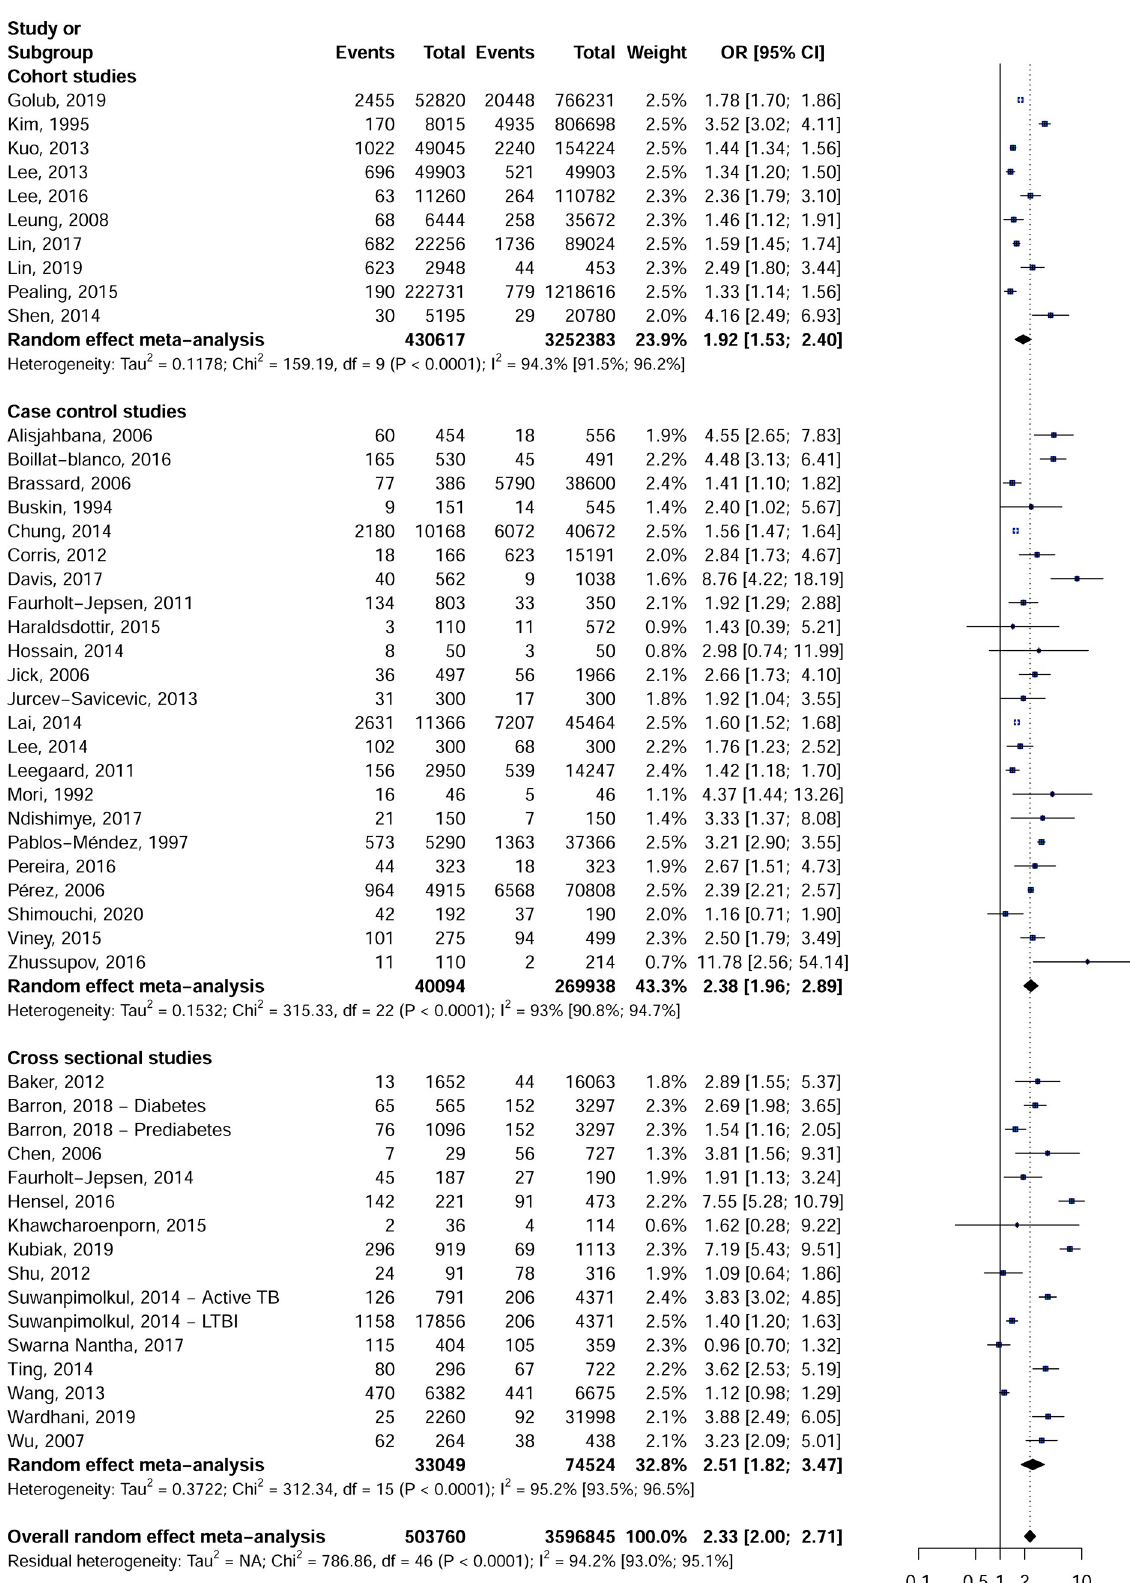
Fig 2. Association between diabetes mellitus and risk of tuberculosis in cohort, case control and cross-sectional studies. https://doi.org/10.1371/journal.pone.0261246.g002 PLOS ONE | https://doi.org/10.1371/journal.pone.0261246 December10,